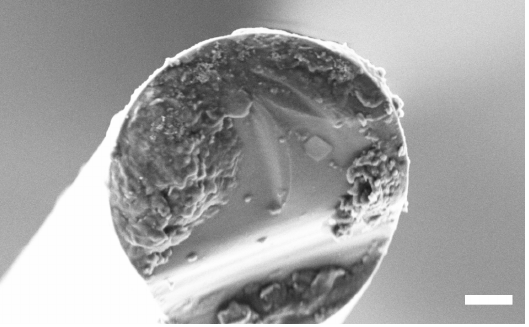
Figure 10. SEM images of the fibre cross-sections of 18-06 (scale bar